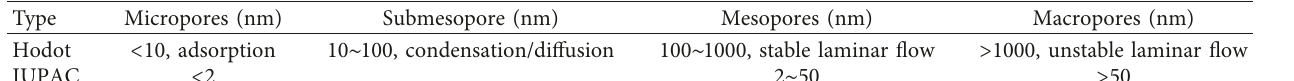
Table 2: Pore size